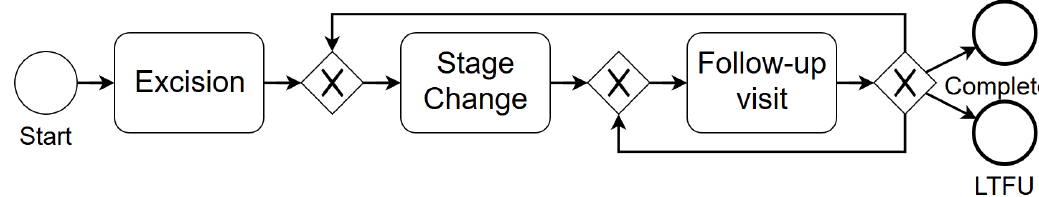
Figure 1. A Business Process Modeling and Notation (BPMN) representation of the process of melanoma surveillance. The start event of the surveillance is the excision of the melanoma followed by the American Joint Committee on Cancer (AJCC) stage classification and the follow-up visits. Depending on the AJCC stage, the number of follow-up visits can vary and the AJCC stage can be re-assessed after each follow-up visit. A patient can be lost to follow-up or complete the surveillance